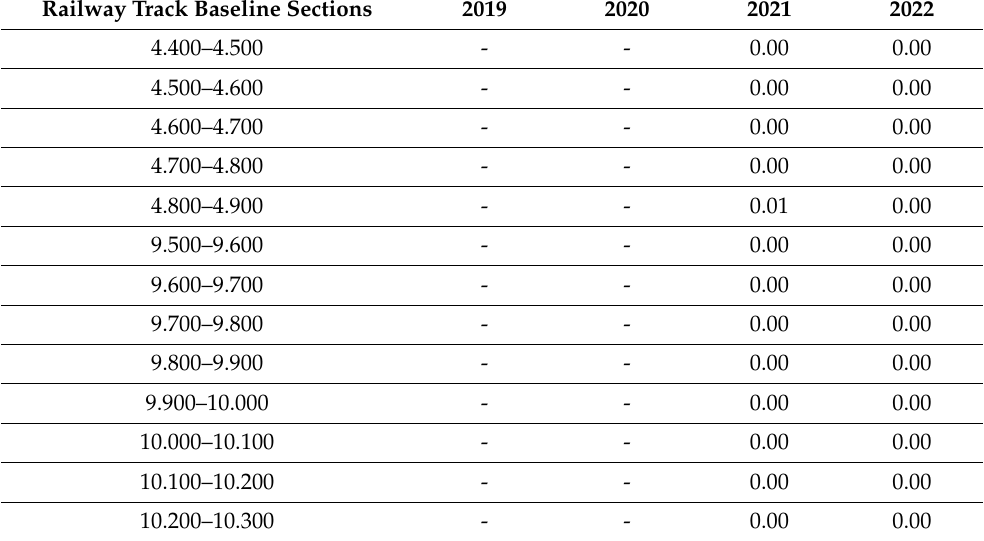
Table A9. Estimates of the railway track condition—relative D 5 object No. R 161_1. Railway Track Baseline Sections